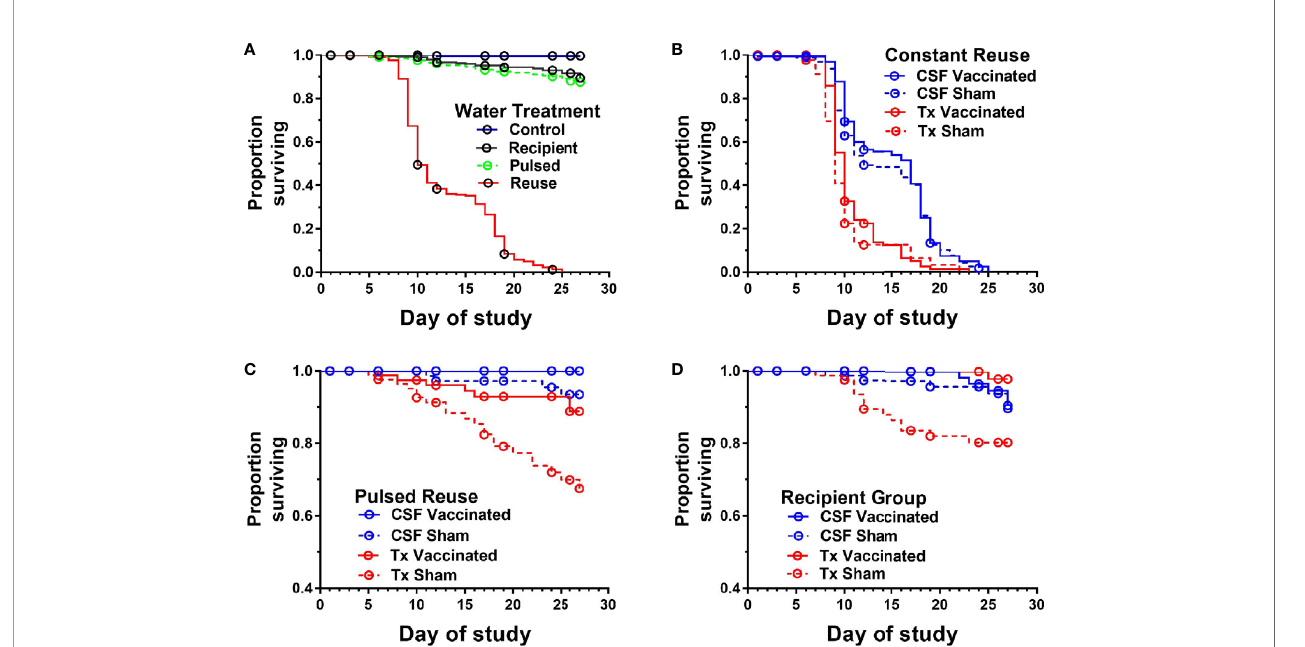
minimal ( Table 3 , Control: CSF vs Tx and Recip: CSF vs Tx).